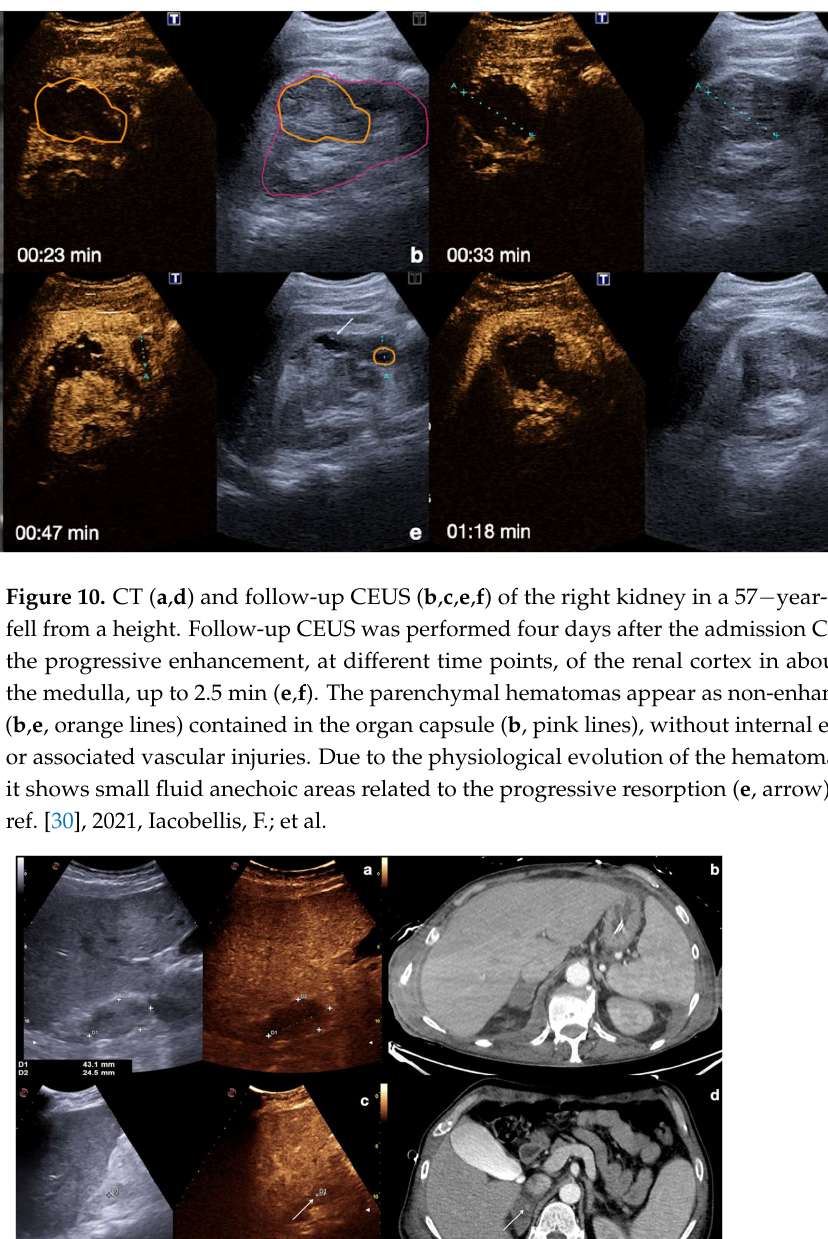
Figure 12. Example of CEUS imaging of low grade (first column) and high grade (second column) injuries in the liver ( a ) and spleen ( b ) after moderate energy blunt trauma. Orange lines indicate parenchymal lacerations/haematomas.